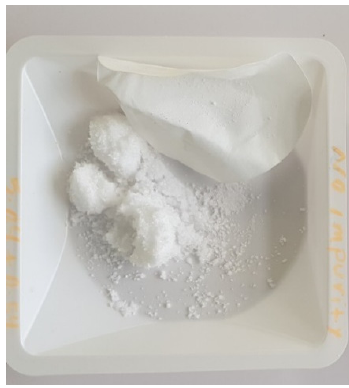
Figure 3. Paracetamol batch crystallized in the absence of the PAP impurity.